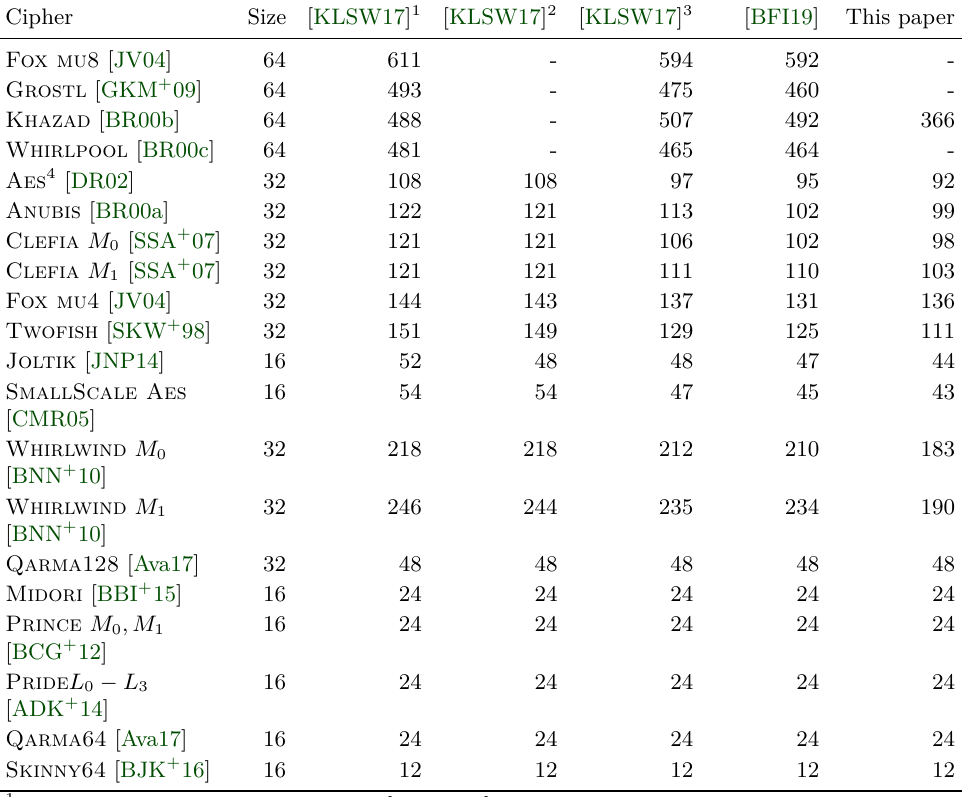
Table 1: Implementation cost of cipher matrices under different optimization